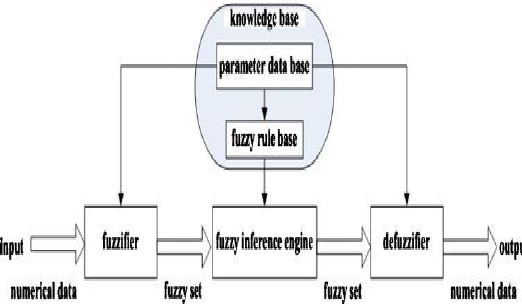
Figure 1. General Fuzzy Inference